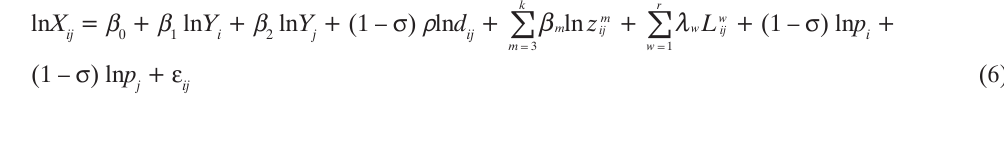
In this model four assumptions are made. Firstly, all goods are differentiated by place of origin (Armington Assumption). In other words automobile products from South Africa country is specialised in the production of only fixed. Finally, preferences of consumers are homothetic (approximated through a constant elasticity of substitution utility function). Equation 3 is generated by performing logarithmic transformation on Equation